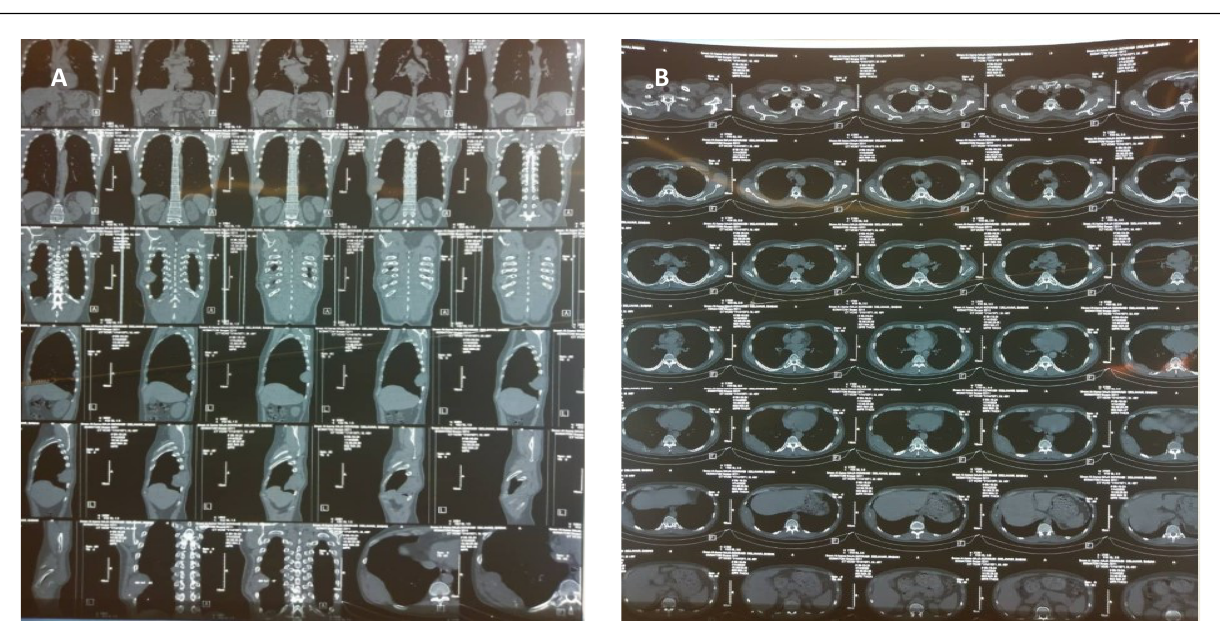
Figure 1 (A.B): Computed tomography scan rib involvement in the right